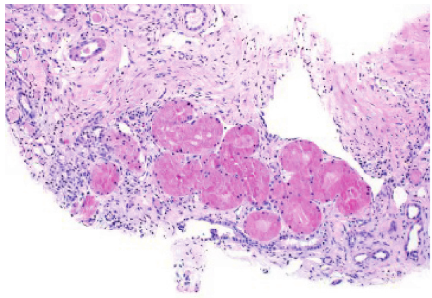
Figure 4: Tubules with protein resorption droplets.